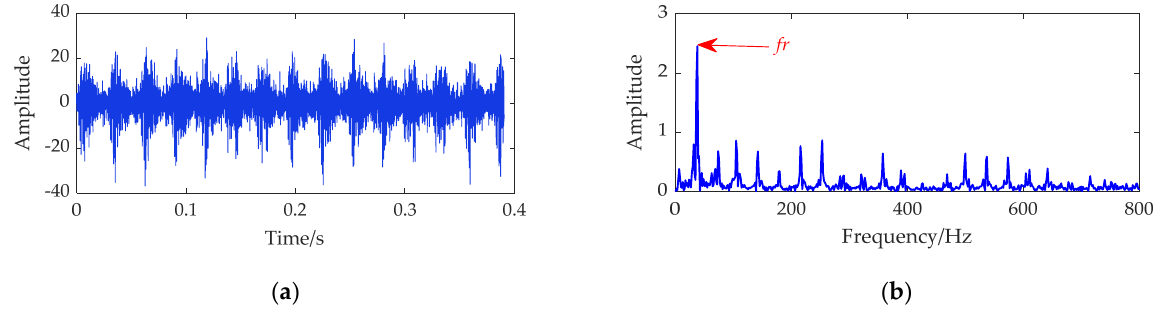
Figure 9. Time-domain waveforms ( a ) and envelope spectrum ( b ) of inner ring fault signal. ( a ) Time-domain waveform. ( b ) Envelope spectrum. CLNGO-FMD was used to decompose the signal. The optimal parameters of FMD were L = 69 and n = 4. The convergence curve of SPC (Figure 10a) and the time-domain (Figure 10b) of each mode showed that the signal was decomposed into three layers.